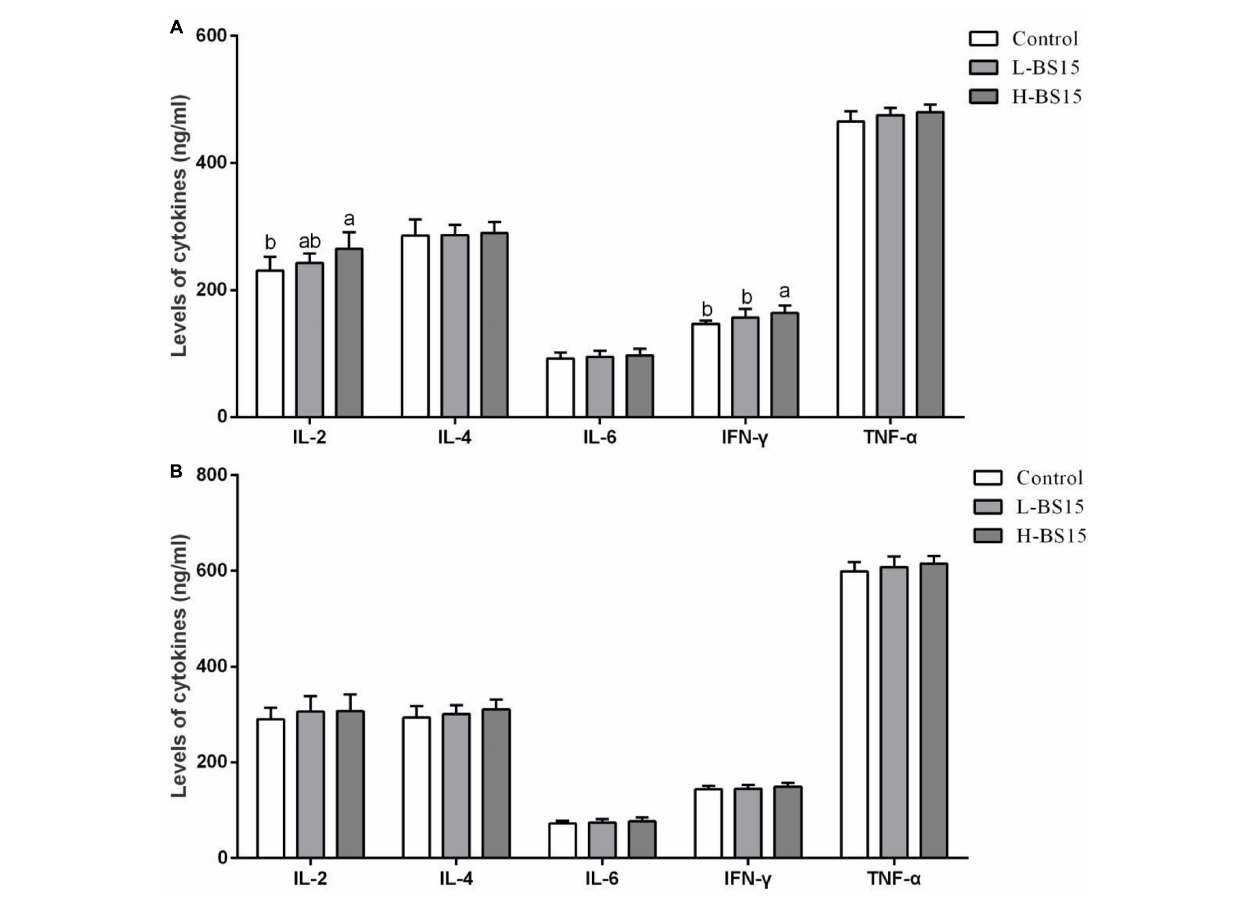
FIGURE 8 | Levels of cytokines in the serum at days 21 and 42 (Experiment 1). Bars with different letters are significantly different on the basis of Duncan’s multiple range tests ( P < 0.05). Data are presented as mean ± standard deviation (six replicates of one chick per cage). (A) Changes of IL-2, IL-4, IL-6, INF- γ , and TNF- α in the serum at days 21; (B) changes of IL-2, IL-4, IL-6, INF- γ , and TNF- α in the serum at days 42. TNF- α tumor necrosis factor-alpha; INF- γ interferon-gamma.